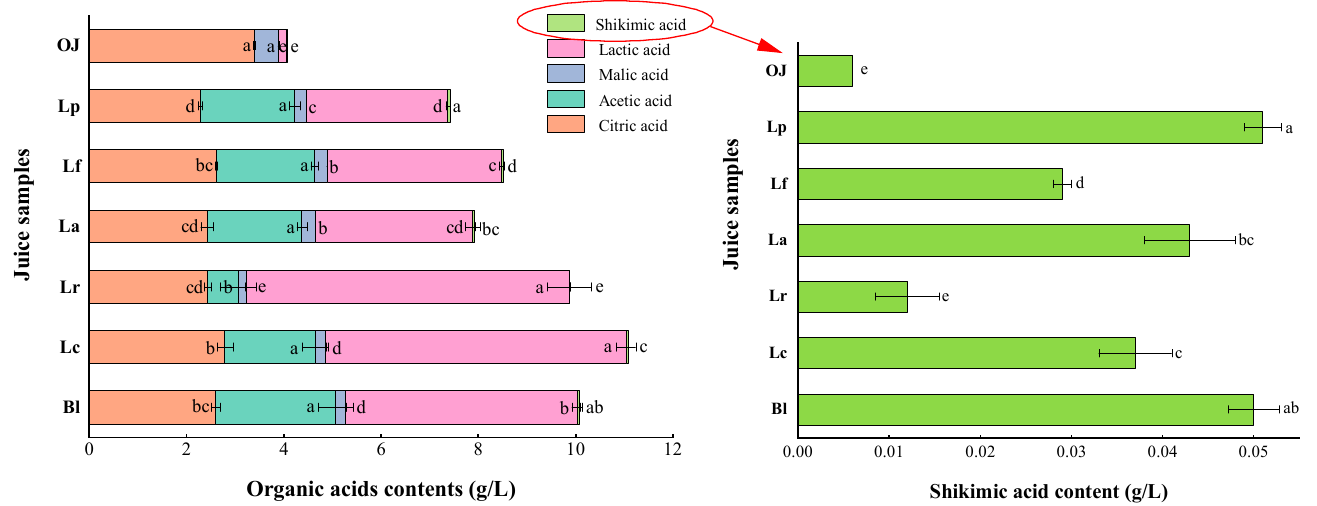
Figure 2. Organic acids contents of the orange juices fermented by Lactiplantibacillus plantarum (Lp), L . fermentum (Lf), L . acidophilus (La), L . rhamnosus (Lr), L . paracasei (Lc), Bifidobacterium longum (Bl) and control ( n = 3). Control (OJ) was original orange juice. a–e Different letters in the same column indicate significant differences ( p < 0.05).